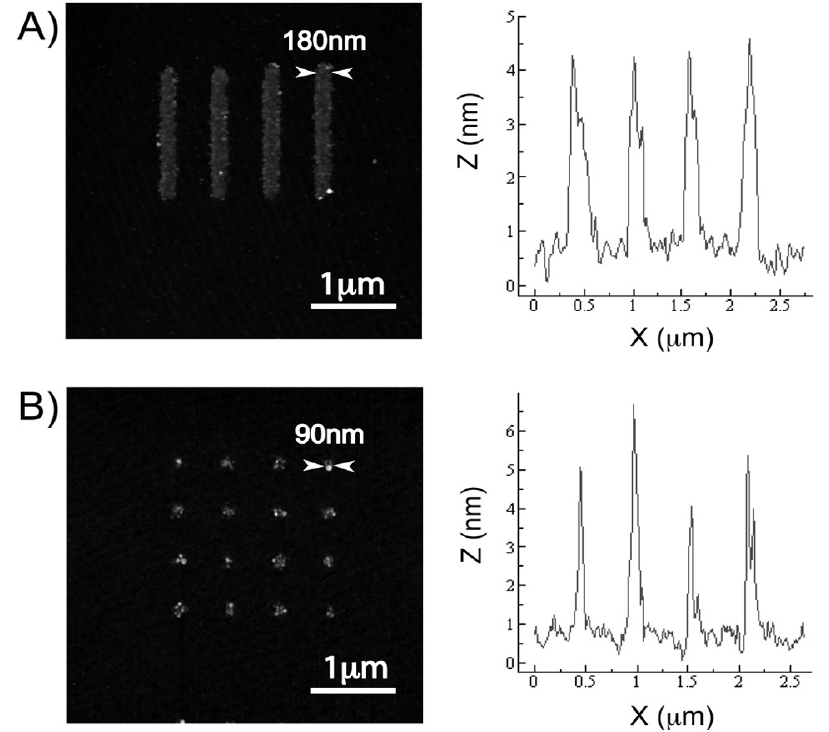
Figure 5. Atomic force microscopy images and the cross-sectional profiles of patterned fibronectin nanoarrays—(a) 180nm lines and (b) 90nm spots. The fibronectin patterns were replicated with high fidelity from the parylene templates. The cross-sectional profiles were taken from a span across four array features on each image, and the full width at half maximum of each peak was measured as the feature width. The heights of the patterned fibronectin features were relatively uniform at 4–5nm. Reproduced with permission from reference [7]. Copyright 2010 American Chemical